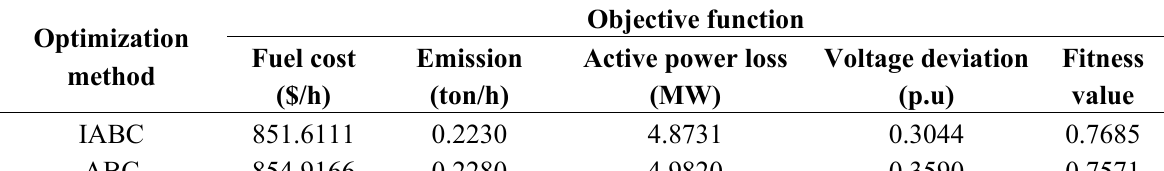
Table 6. Results obtained by the different algorithms for fuzzy multi-objective OPF.